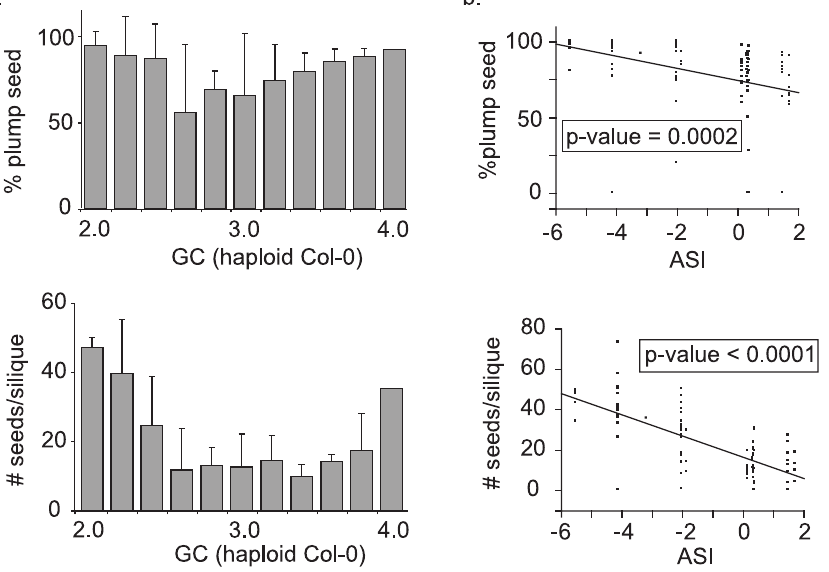
Figure 4. Biological Relevance of the ASI (A) For each individual in the CWW F 2 population, total number of seed (top panel) and percentage of plump seed (bottom panel) were recorded. Data for all individuals in the same genome content class were pooled, and mean values were calculated (bars). Standard errors are indicated. (B) The relationship between ASI and total seed number (top panel) or percentage of plump seed (bottom panel) was estimated by regression analysis. Both regressions were significant, and p -values are indicated.